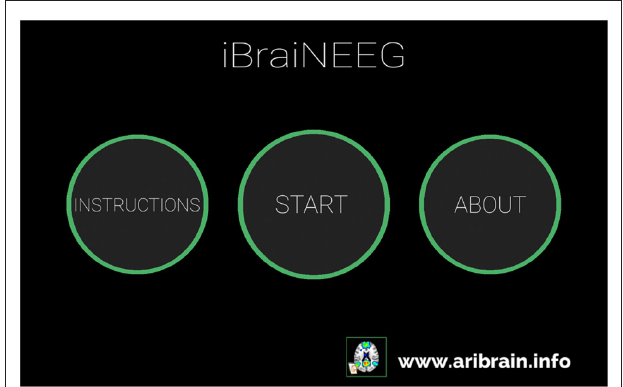
FIGURE 9 | By pressing the bulb on the left of the screen, the name of each of the seven functional connectivity networks (Yeo et al., 2011) appears with a color palette in a window on the right side of the